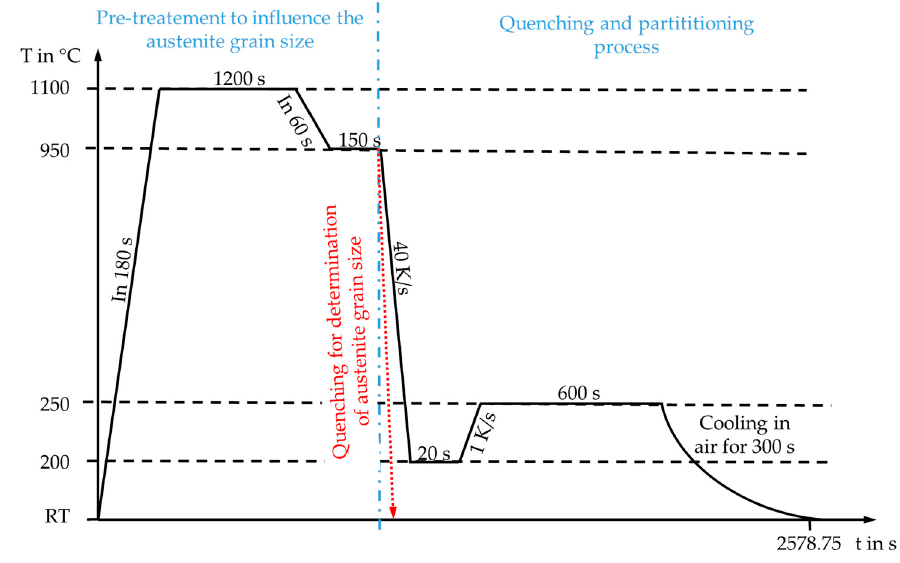
Figure 6. Heat treatment route 2. Grain growth 1.